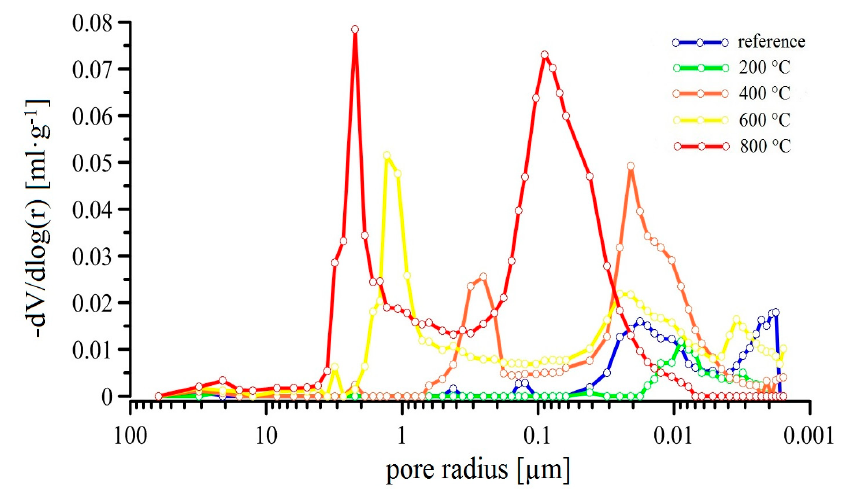
Figure 12. Pore size distribution of UHPC samples after their exposure to high temperatures.